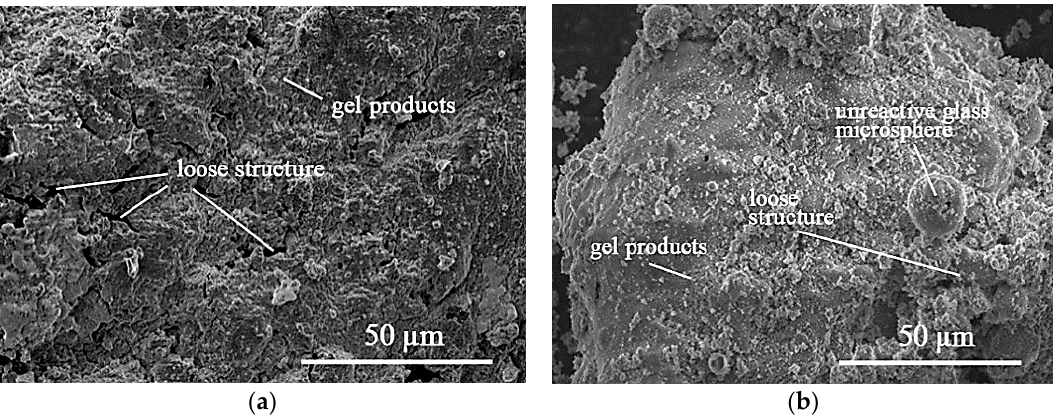
Figure 4. SEM photos of ( a ) control C0 and ( b ) paste C4 cured for 28 days.